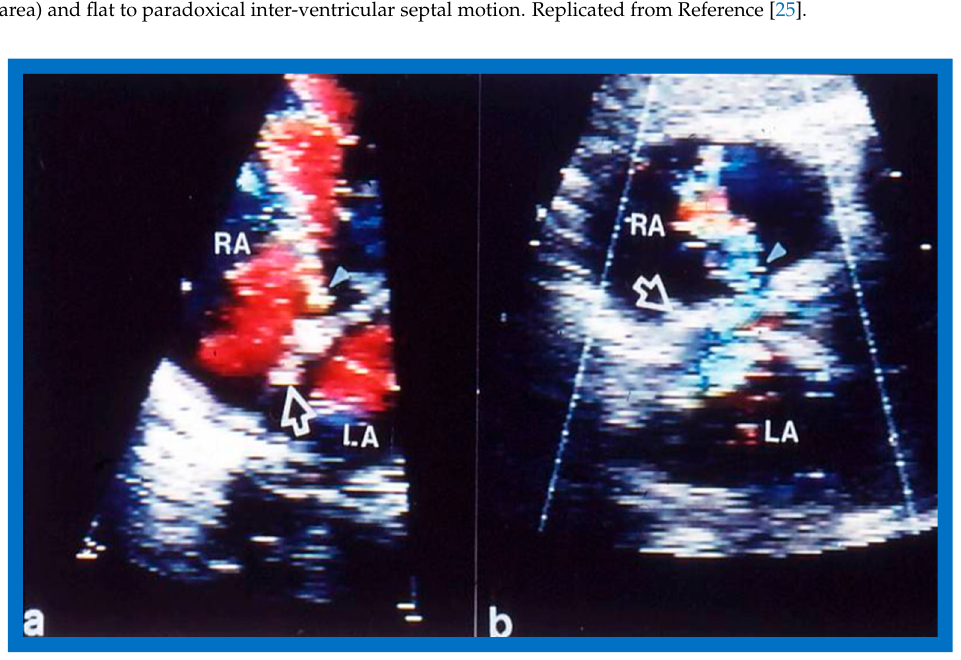
Figure 45. Transthoracic subcostal echocardiographic images of the atrial septum with color Doppler imaging demonstrating the device (unfilled arrow heads) across atrial septal defects in two different patients ( a , b ) with residual shunts (filled arrowheads). LA, left atrium; RA, right atrium. Reproduced from Reference [4]. Table 1. Method for classifying left-to-right atrial shunt by echocardiography.